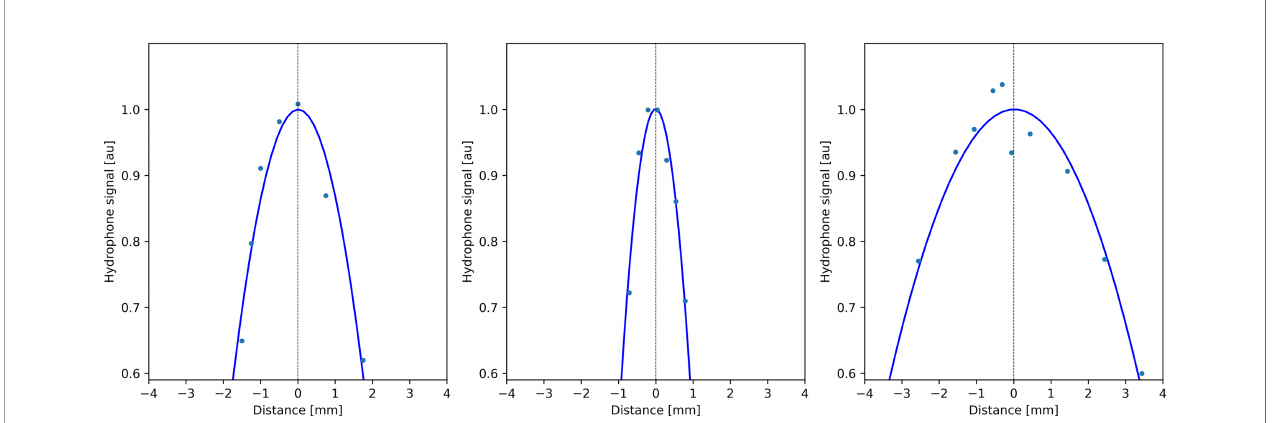
Figure 8 . Outside the sternum and the focal area, MRI follow-up did not indicate thermal lesions, such as on the rib cage, in the subcapsular, or within the abdominal wall.